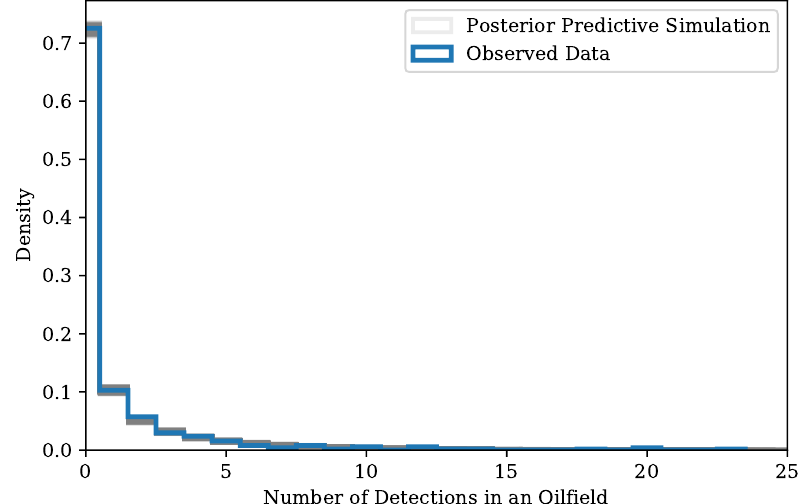
Figure 17. Histograms for the distribution of the field detection counts from October 2018. Blue: original data observed by VIIRS. Gray: posterior predictive simulation results obtained with Model 6. The simulation results are plotted using gray with transparency, such that the darker gray indicates where the majority of the simulations fall into.